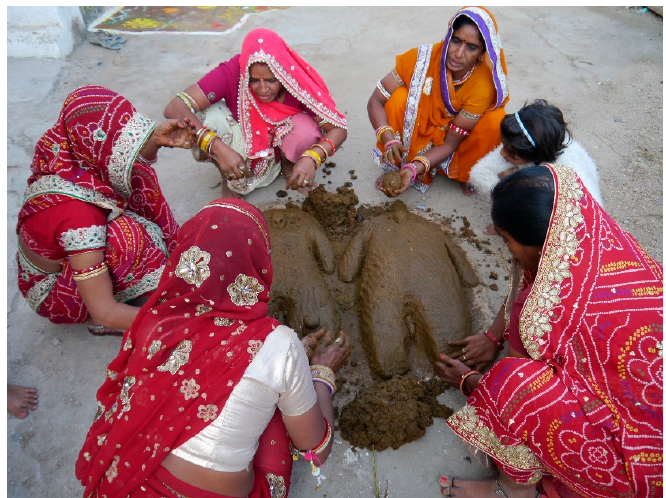
Figure 1. Women kneading sacred cow dung sculptures, Badi 2017 (picture by author).